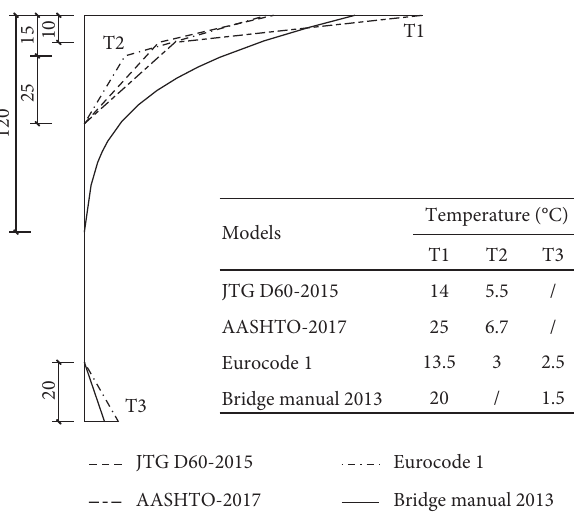
Figure 20: Vertical temperature gradient model (unit: